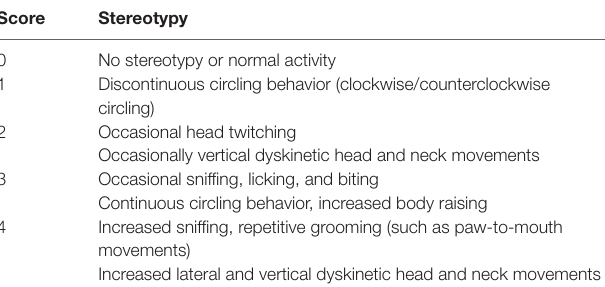
TABLE 1 | Behavior assessment with reference to grades of